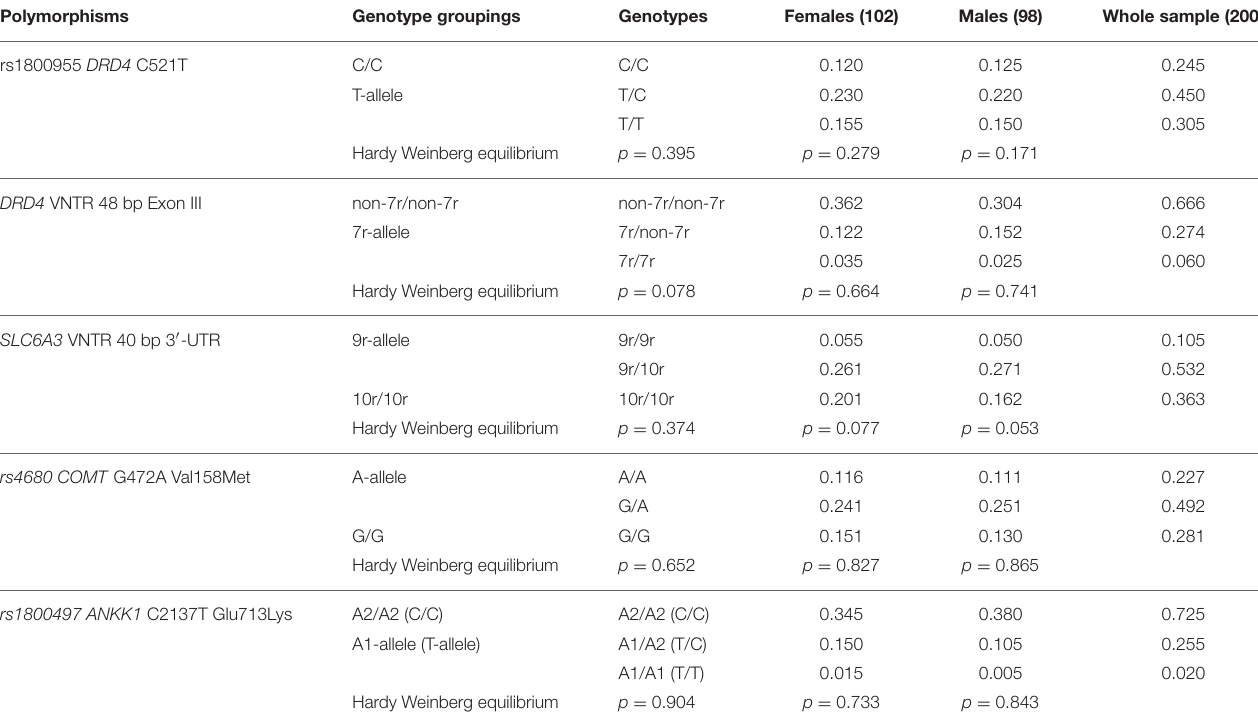
TABLE 1 | Genotype frequencies and Hardy Weinberg equilibrium statistics for each genetic variant in the whole sample (males plus females) and in the two separate genders.